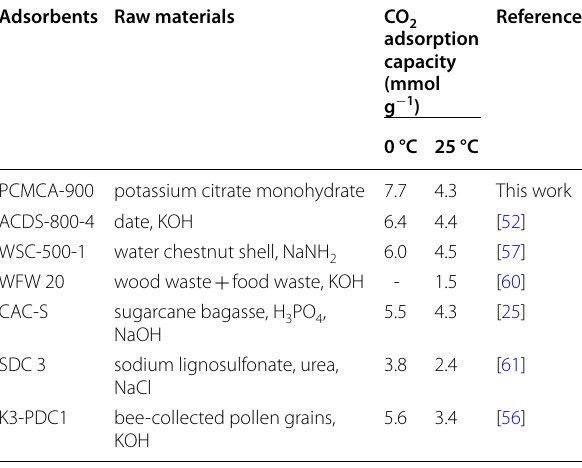
adsorption capacity of the 2